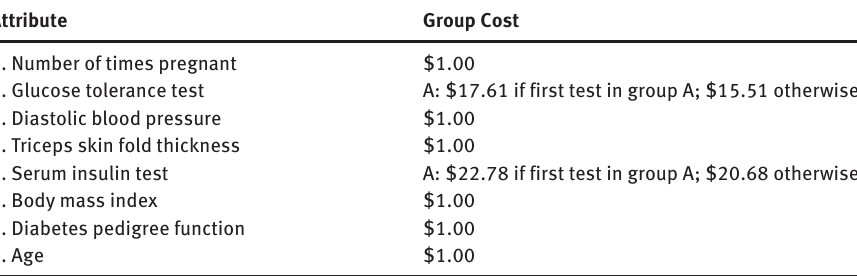
Table 9. Measurement Cost of Attributes in Diabetes Data Set. Attribute